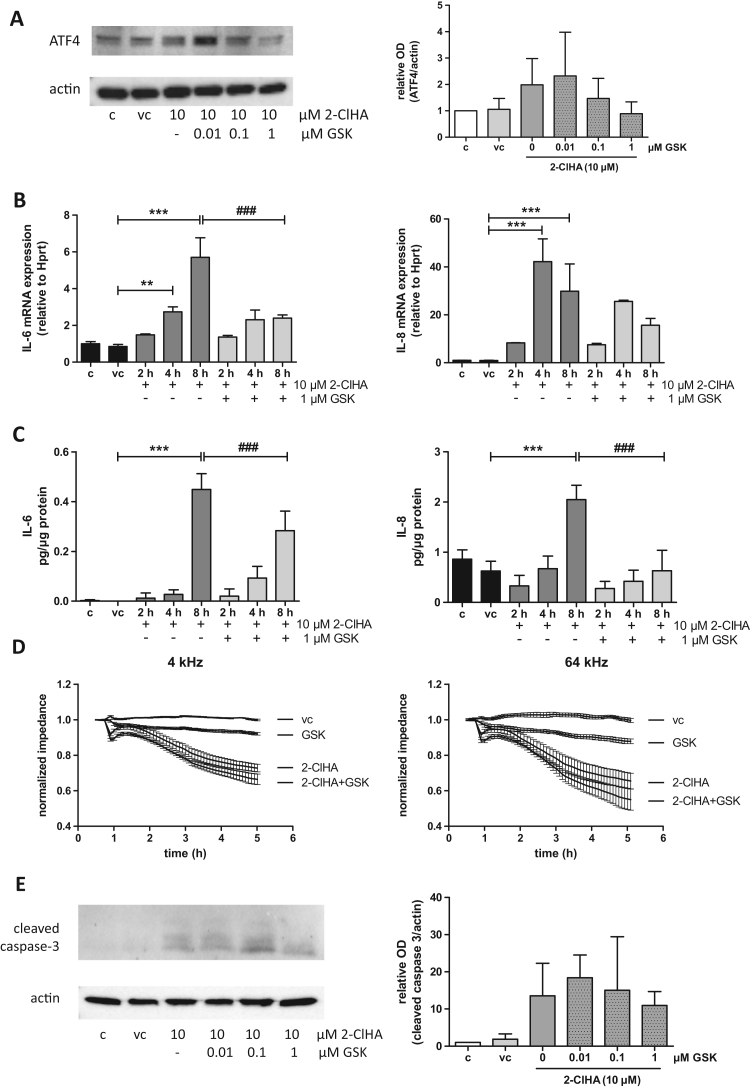
PERK inhibition attenuates the inflammatory response but not barrier dysfunction and caspase-3 activation of hCMEC/D3 cells. (A) Serum-starved cells were incubated in the absence (c) or presence of DMSO (0.1%, vehicle control, vc) and 2-ClHA in the absence or presence of different concentrations of GSK2606414 (GSK) for 4 h. Expression levels of ATF4 were examined by Western Blot analysis. One representative blot out of three is shown. Bar graph represents densitometric analyses of immunoreactive bands relative to β-actin (mean + SD; n = 3). (B) Serum starved cells were incubated in the absence (c) or presence of 2-ClHA plus GSK for the indicated time periods. DMSO (0.1%) served as vehicle control (vc). IL-6 (left) and IL-8 (right) mRNA levels were determined by qPCR normalized to Hprt. Values are expressed as mean + SD from three independent experiments performed in triplicates. Expression was calculated using the 2-ddCt method. (C) Cells were treated as described in (B). The supernatants were collected and IL-6 (left) and IL-8 (right) concentrations were determined using ELISA. Results (normalized to protein content) represent mean + SD from three independent experiments performed in triplicates. (*, p < 0.01; one-way ANOVA with Bonferroni correction). (D) For ECIS measurements cells were plated on collagen-coated gold microelectrodes and cultured to confluence. After stabilization, DMSO (0.1%; vehicle control, vc) or 2-ClHA (10 μM) alone or in combination with 1 μM GSK was added to the cells. Impedance of cell monolayers was continuously monitored at 4 and 64 kHz. (E) Cells were treated as in (A). Caspase-3 cleavage (17 kDa) was evaluated by Western blot analysis (c = no addition; vc = DMSO). One representative Western blot out of three is shown. Densitometric and statistical evaluation is shown in Fig. S4.